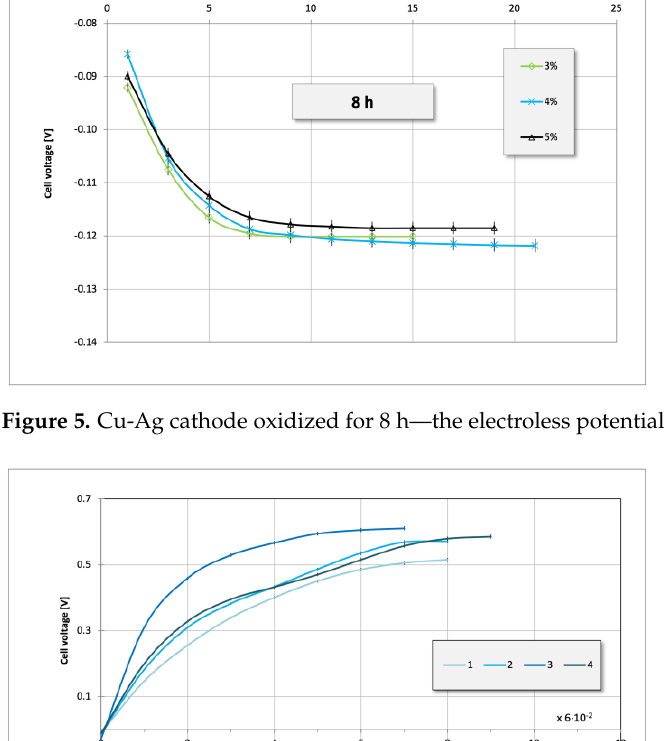
Figure 4. Cu-Ag cathode oxidized for 6 h — the electroless potential of cathode.